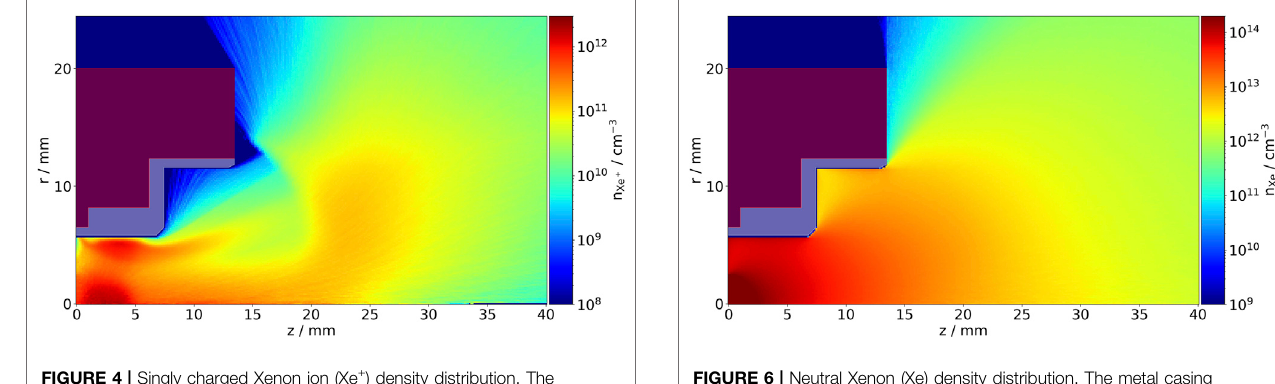
FIGURE 4 | Singly charged Xenon ion (Xe + ) density distribution. The metal casing (transparent red) and dielectric (transparent white) are also denoted.